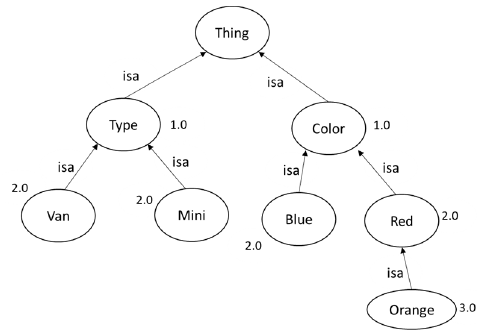
Figure 5. Part of an ontology represented as tree.